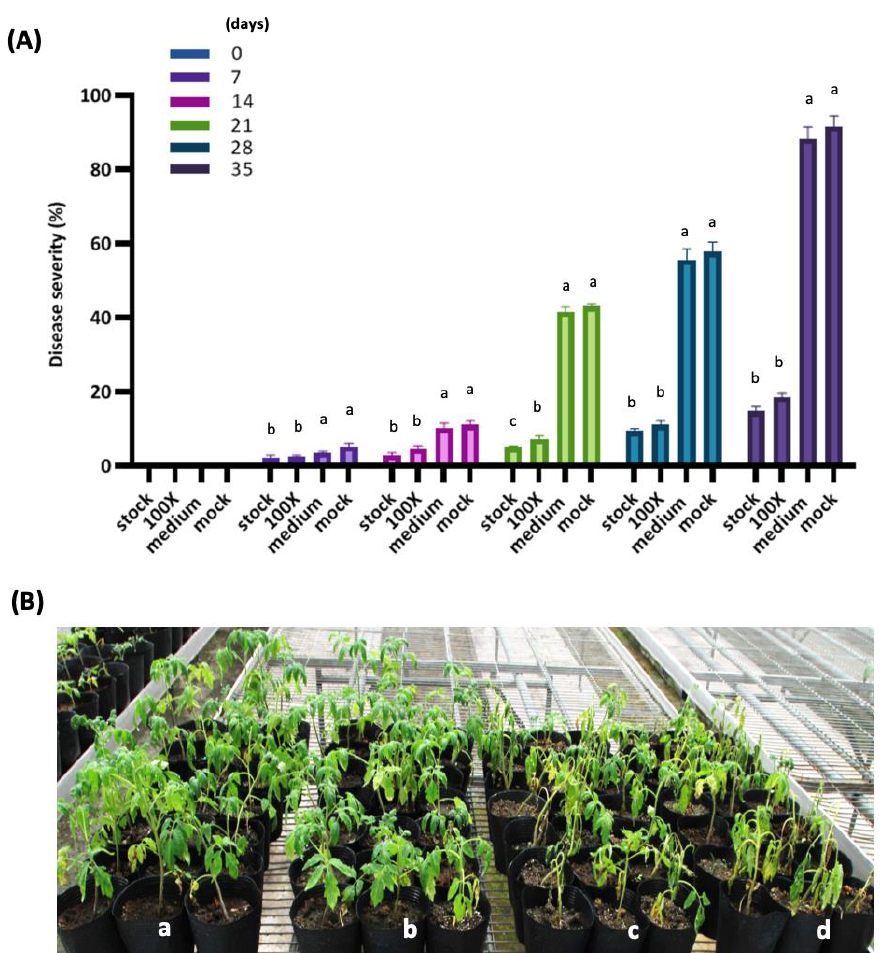
Figure 3. The effect of the Bacillus amyloliquefaciens PMB01 strain on controlling bacterial wilt of tomatoes in greenhouse conditions. ( A ) The disease severities of bacterial wilt were determined on days 0, 7, 14, 21, 28 (last treatment of PMB01), and 35. Means within the columns followed by different letters are significantly different according to Tukey’s HSD analysis ( p < 0.05). ( B ) Images of tomato plants after being treated with or without PMB01 fermentation broth on day 35. Treatments: undiluted stock ( a ); 100X (100-fold dilution) ( b ); medium only (medium) ( c ); and water control (mock) ( d ).